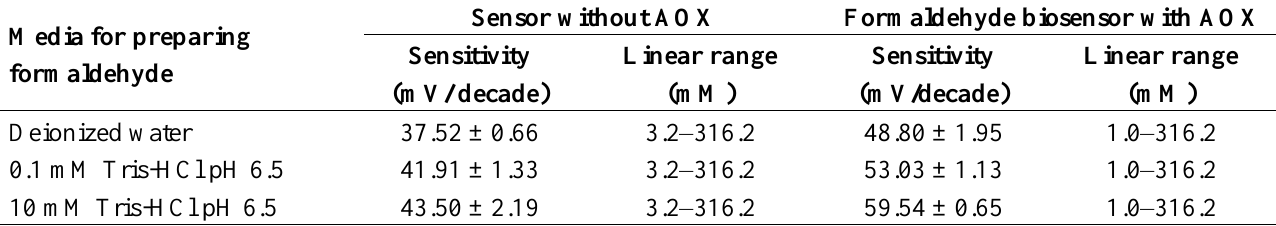
Table 2. A comparison of responses between sensors with and without AOX enzyme in various media. Media for